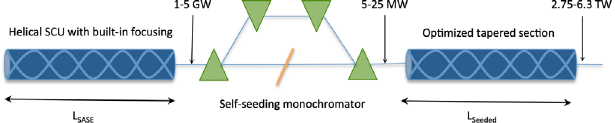
FIG. 1. Schematic of the undulator for hard x-ray multi-TW peak power output, designed to achieve high extraction efficiency in the shortest possible distance.